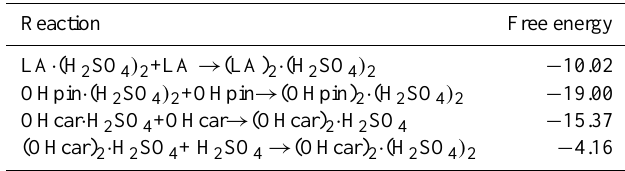
Table 4. Formation free energies (kcalmol − 1 ) calculated for differ- ent clusters containing one organic acid molecule and one sulphuric acid molecule.